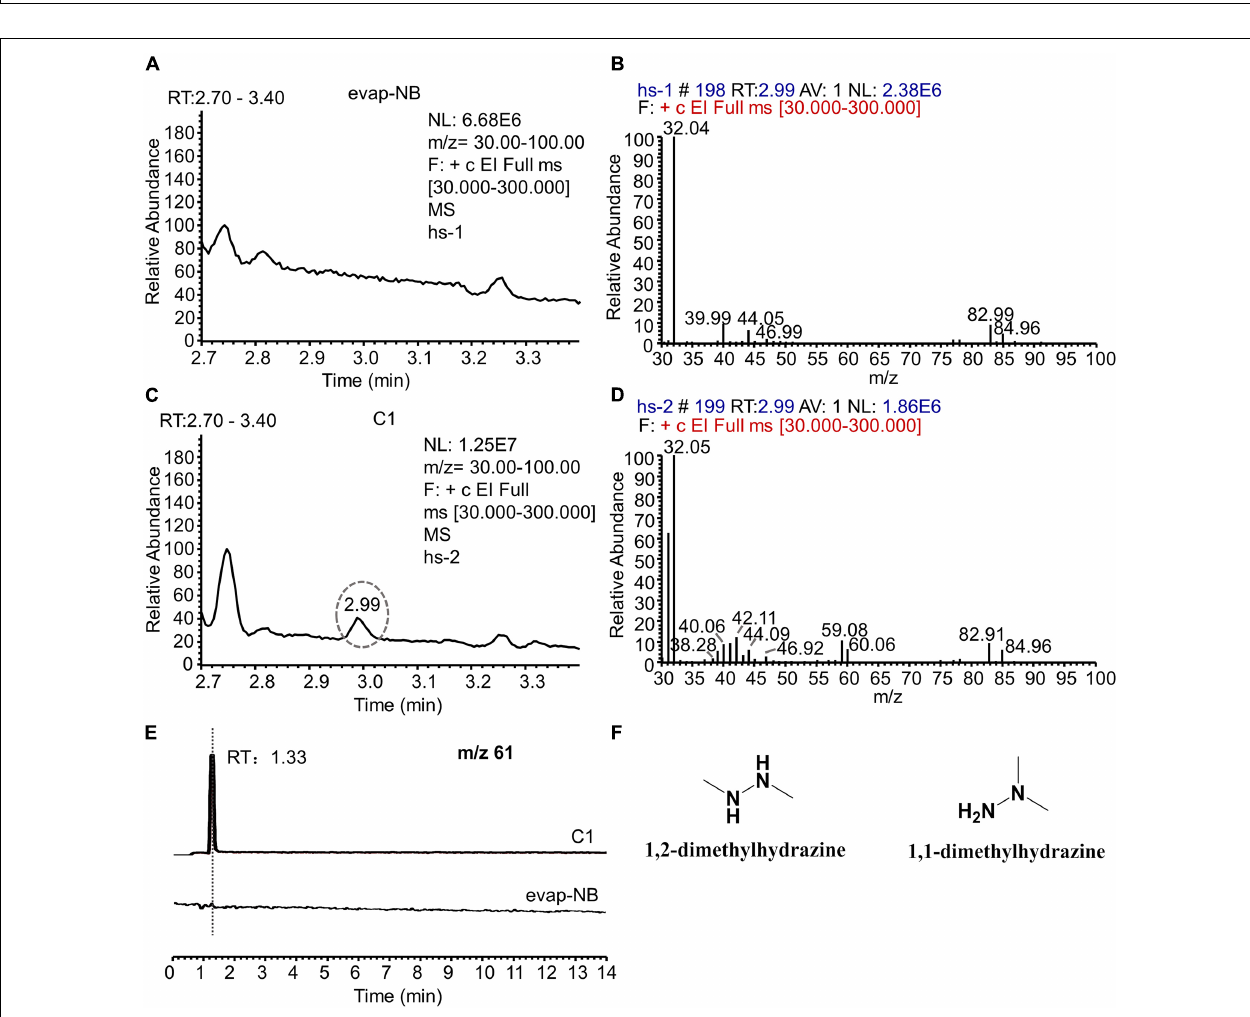
FIGURE 6 | GC-MS and LC-MS analysis of evap-NB and C1. (A) Gas chromatogram of evap-NB. (B) Mass spectra of peak in chromatogram A at 2.99 min. (C) Gas chromatogram of C1; (D) mass spectra of peak in chromatogram C at 2.99 min. (E) Single ion monitoring of m/z 61. (F) Structure of 1,2-dimethylhydrazine and 1,1-dimethylhydrazine. GC-MS, gas chromatography–mass spectrometry; LC-MS, liquid chromatography–mass spectrometry.